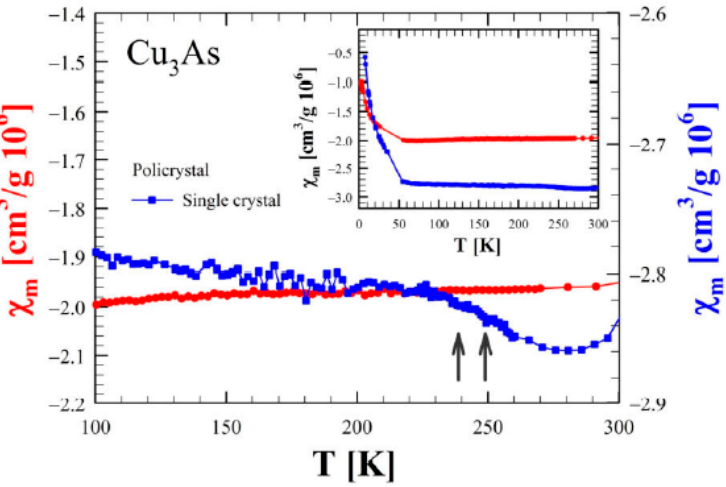
Figure 17. Magnetic susceptibility (in CGS units) as a function of temperature between 100 and 300 K for both single crystal (blue line and scale on the right) and a polycrystalline sample (red line and scale on the left) of Cu 3 As. Measurements were performed using an external magnetic field of 1 T oriented perpendicular to the a–b plane for the single crystal. The inset shows an overview of the data from 5 to 300 K.